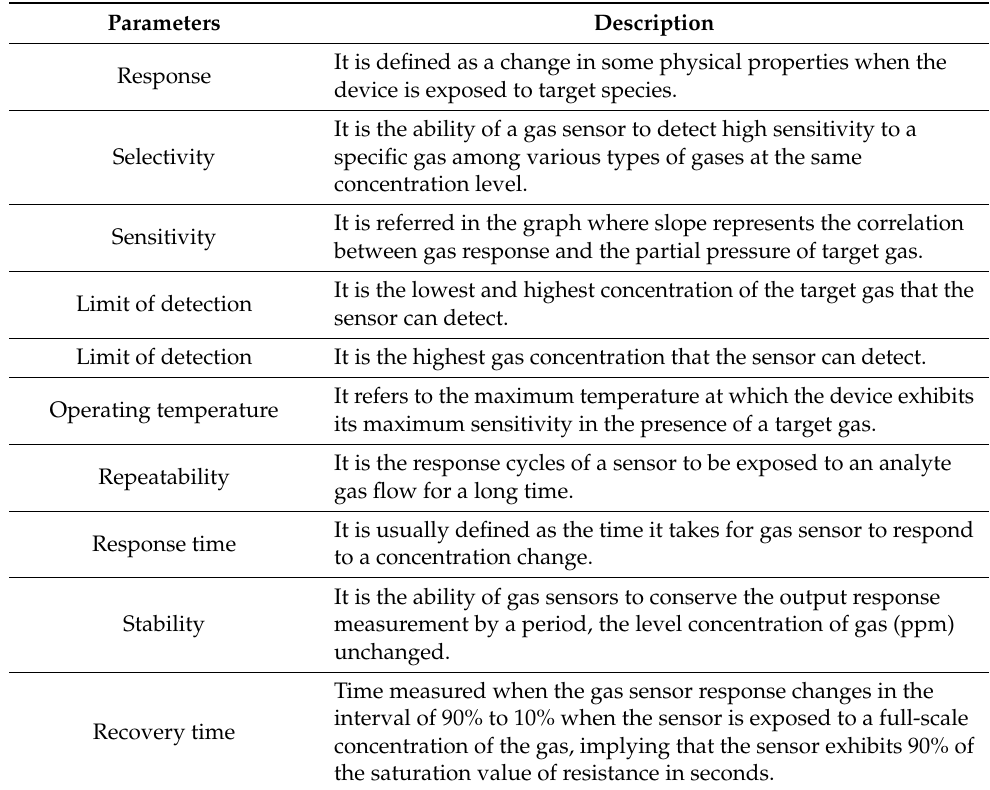
Table 1. The main parameters of a gas